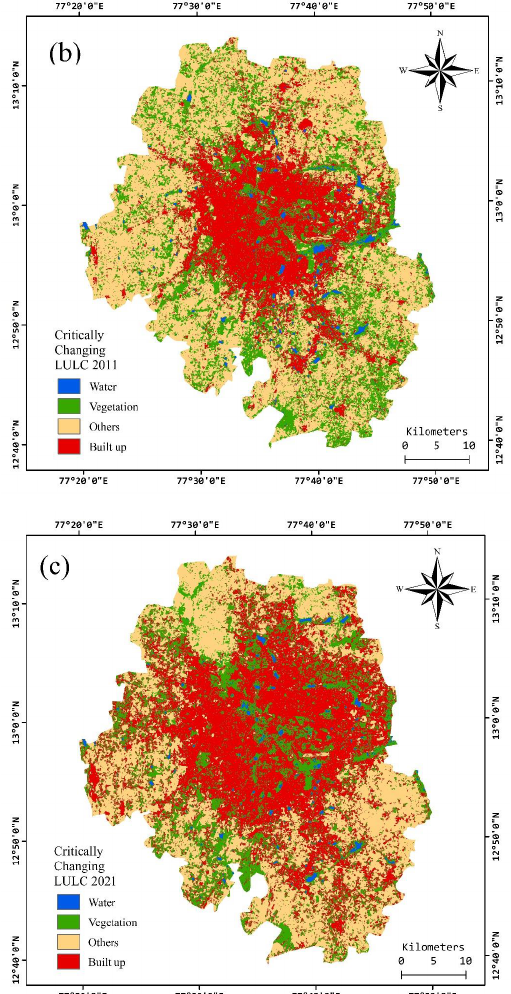
Figure 3. Land use and land cover SVM classifier, ( a ) 2021, ( b ) 2011, and ( c ) 2021. In 2001, the built-up area was covered by 21.16% of the total Bangalore area of 462.49 km 2 . In 2011, urban areas increased to 553.40 km 2 , which is 25.32% of the total area. The total built-up area reached 867.73 km 2 in 2020, 39.70% of the entire Bangalore city.